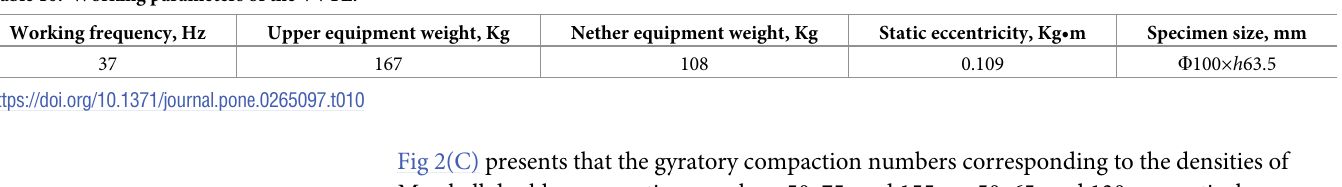
Table 10. Working parameters of the